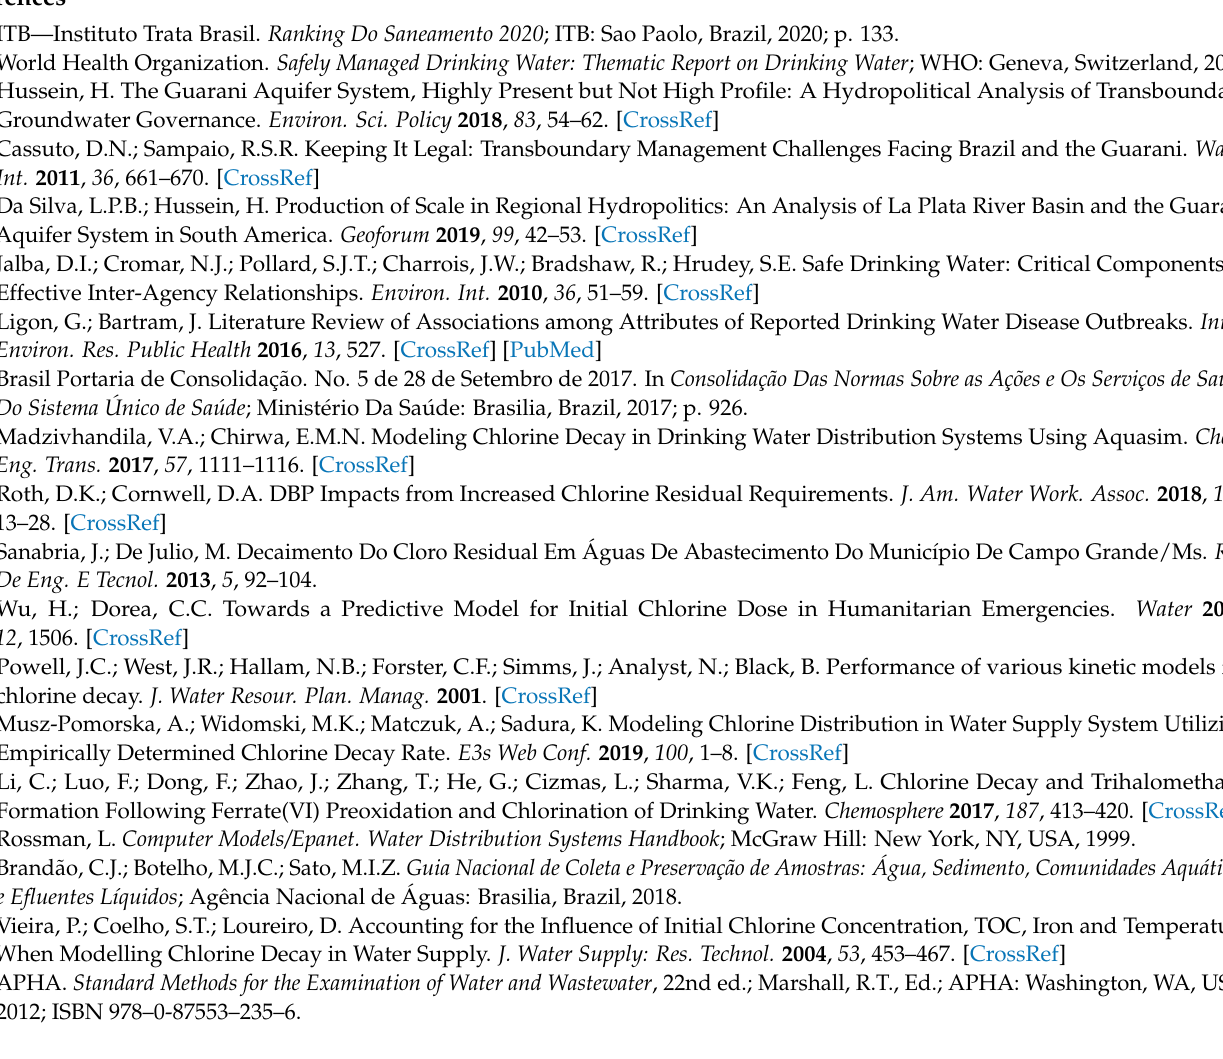
Velho. Table S3: Results of the analysis of variance of data on chlorine decay speed in water samples from tubular and excavated wells located in Porto